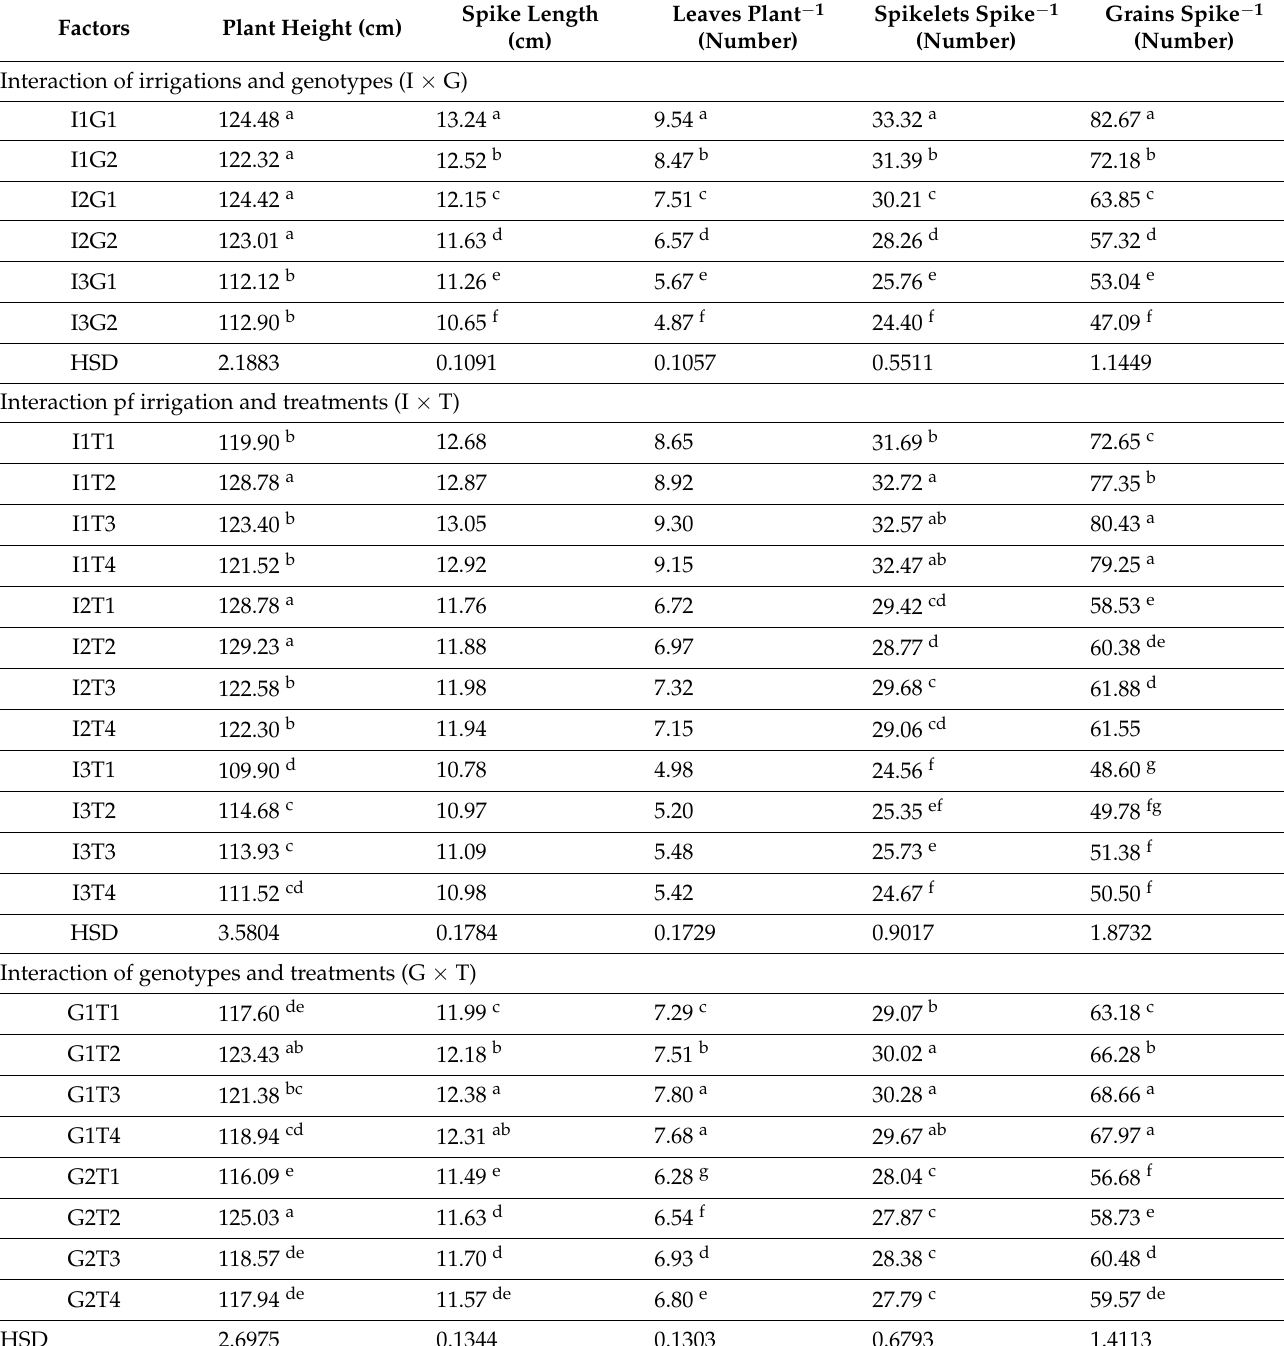
(Table 5). In case of interactions between varieties and treatments, a maximum increase in plant height was observed at G 2 T 2 which is statistically similar to G 1 T 2 , while the minimum value was at G 2 T 1 (Table 5). In case of leaves per plant, spike length, spikelets per spike and grains per spike of triticale, the highest increment in said parameters was observed at G 1 T 3 , while the lowest value was recorded at G 2 T 1 (Table 5). Table 5. Interactive response of two factors regarding plant height, spike length, number of leaves per plant, number of spikelets per spike and number of gains per spike of triticale